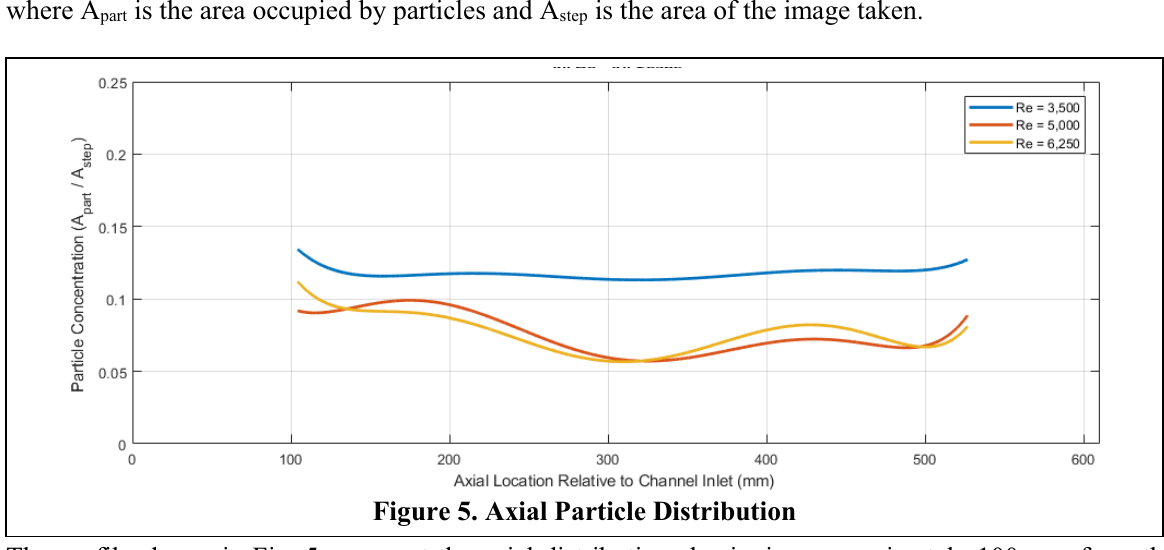
= 3,500 (Right) Re 3